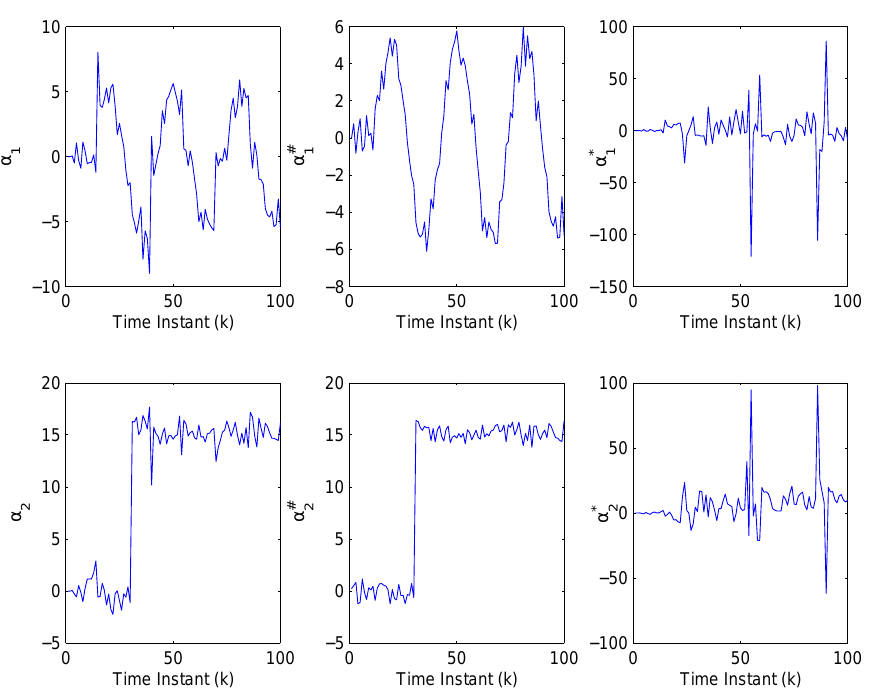
; (cid:11) ♯ and (cid:11) ⋆ k k k